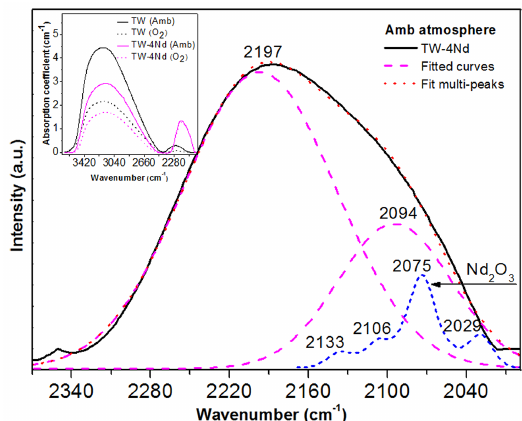
Figure 4. Deconvolution of the absorption band centered at 2200 cm –1 of the TW-4Nd glass prepared in Amb atmosphere and absorption spectra of the pure Nd O . The inset shows the OH absorption 2 3 spectra of the samples prepared in both atmospheres.